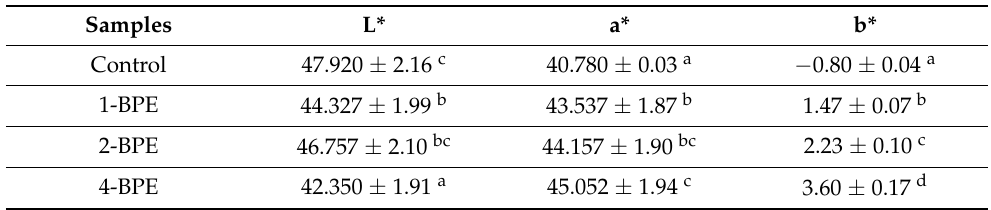
Table 3. Color parameters of